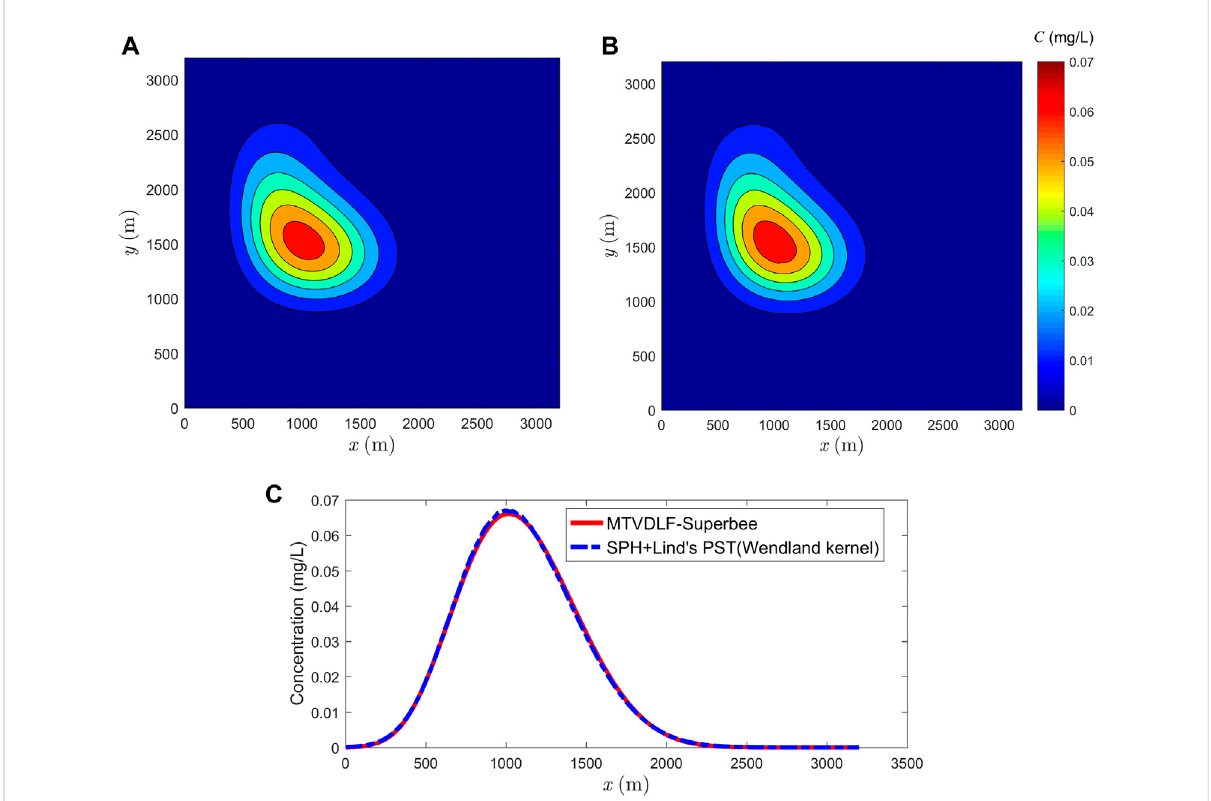
FIGURE 11 Comparison betweenreferencesolution and theresult obtained by SPH combined with Lind ’ s PST. (A) Reference solution yielded byMTVDLF- Superbee, (B) solution of particle scheme (Lind ’ s PST with Wendland kernel) and (C) concentrations along y (cid:2) 1500